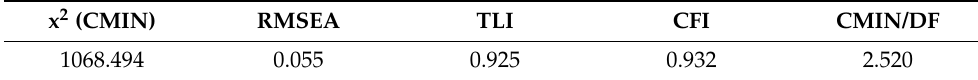
Table 2. Model’s Goodness of Fit